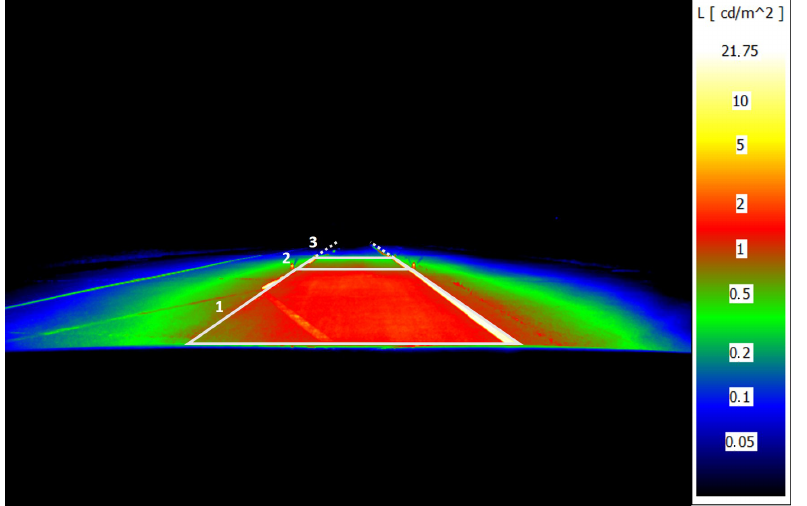
Figure 3. Spatial luminance distribution in the forefield of the test vehicle as obtained for a maximal headlamp PWM value of 255, captured by using a TechnoTeam LMK 5. Area 1 (near field): 0m–20m, area 2 (mid field): 20m–32m, area 3 (far field): > 32m (to vanishing point of